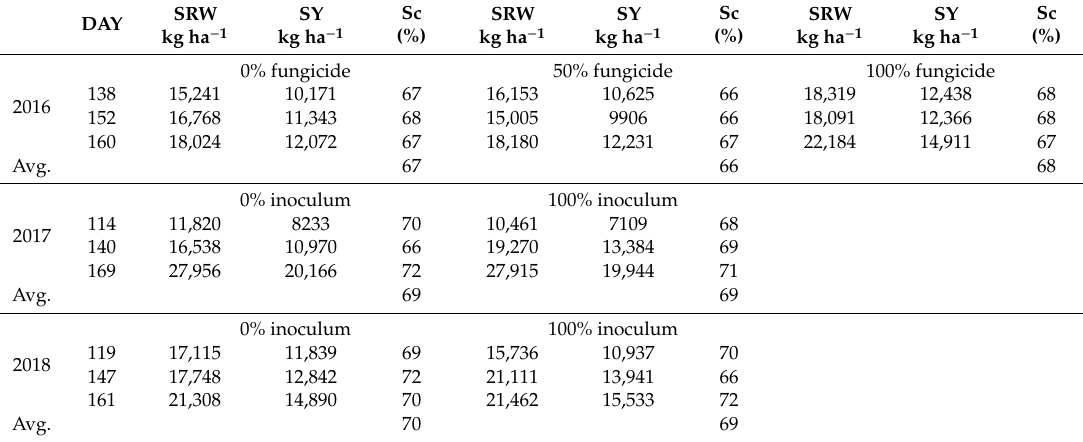
Table 8. Observed storage root weight (SRW) (DM) kg ha − 1 , sugar yield (SY) kg ha − 1 and sugar content as (%) of (DM) (Sc (%)) for three di ff erent fungicide treatments: 0%, 50% and 100% in which 0, 0.5, and 1 L ha − 1 of Spyrale fungicide was applied, respectively, and 0% and 100% inoculum treatments in which 0 and 1 g m − 2 of inoculum was applied,